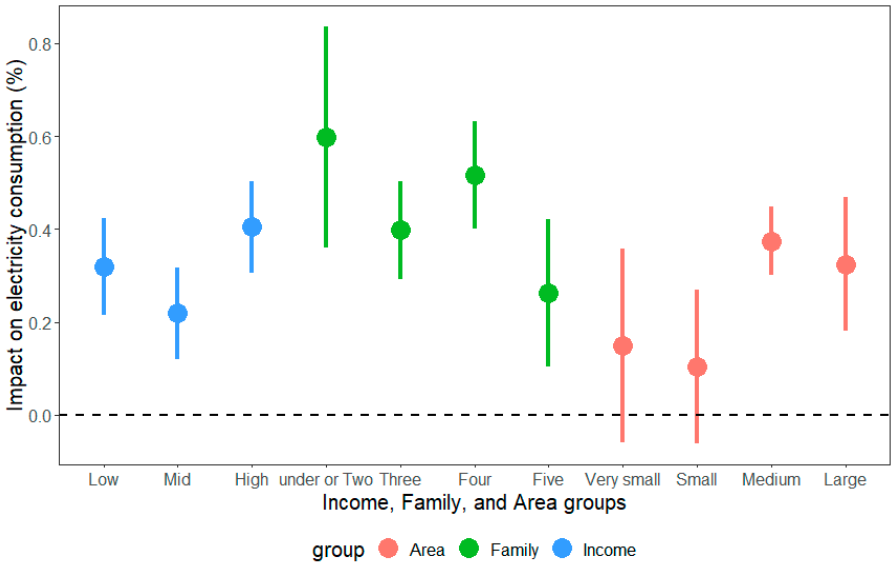
Figure 5. Change in each groups’ household energy consumption due to increase in the time-varying reproduction number of COVID-19.